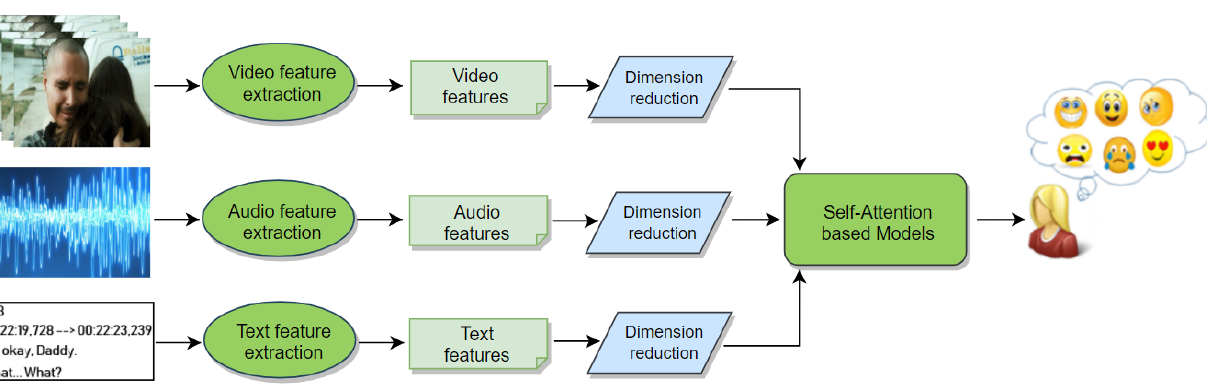
Figure 1. Overview of the proposed AttendAffectNet (ANN). Feature vectors are extracted from video, audio, and movie subtitles. We reduce their dimensionality before feeding them to the self-attention based models, which predict the affective responses of movie